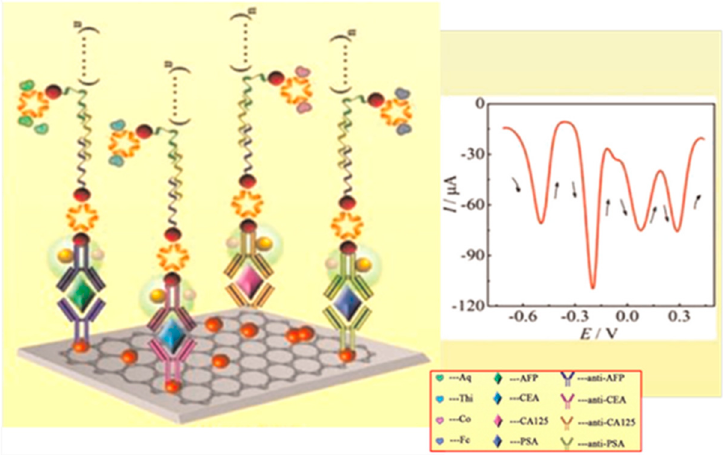
Figure 5. Schematic illustration of the fundamentals for the preparation of a sandwich-type immunosensor for the simultaneous detection of four cancer biomarkers, CEA, AFP, CA125 and PSA. Inset shows an example of the DPV recorded voltammogram. Modified from Ref. [6] with